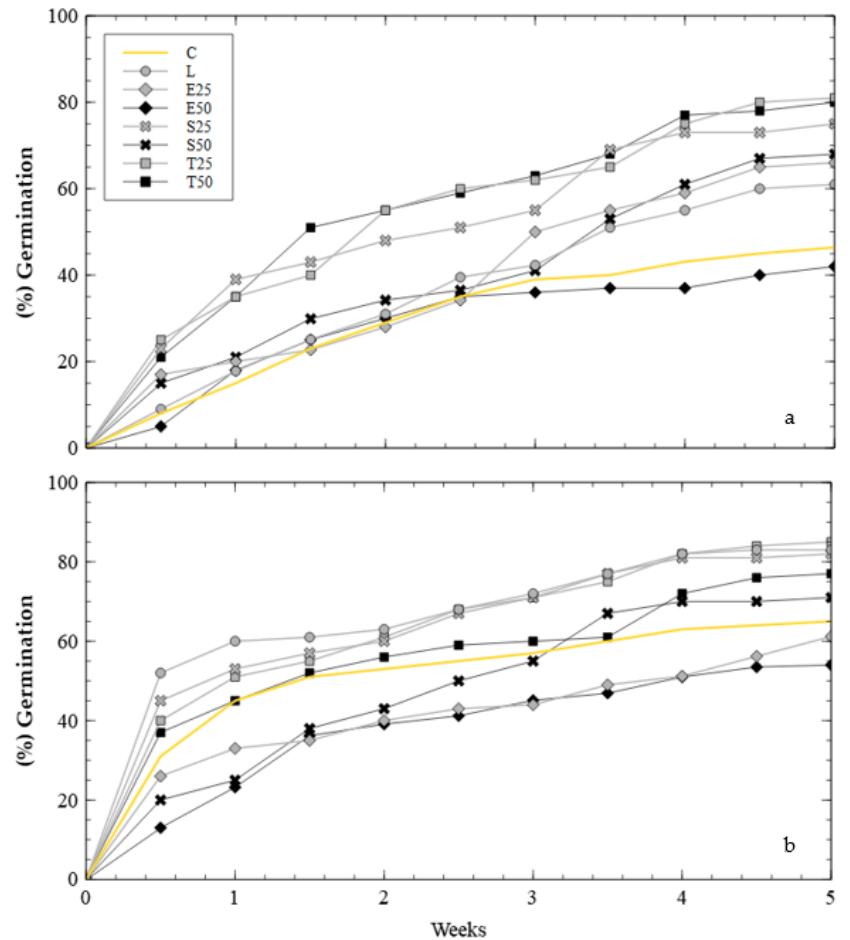
Figure 4. Germination rate: ( a ) samples without NPK; ( b ) samples with NPK.